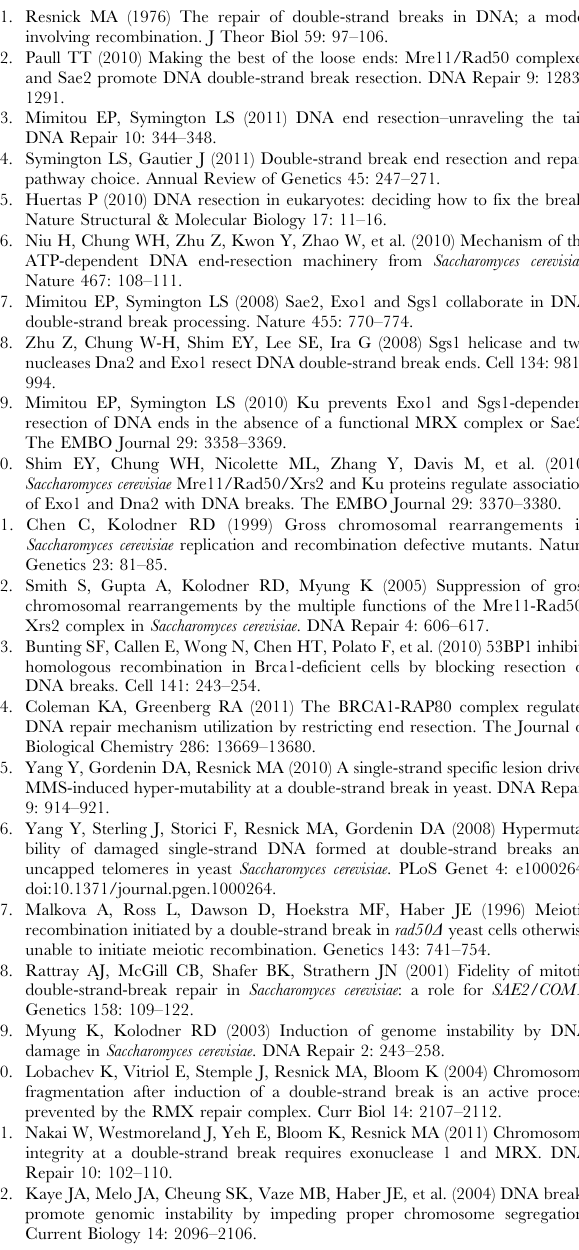
Sce I + SfiI cut circular chromosome 3. All other primer pairs are specific for the right fragment.